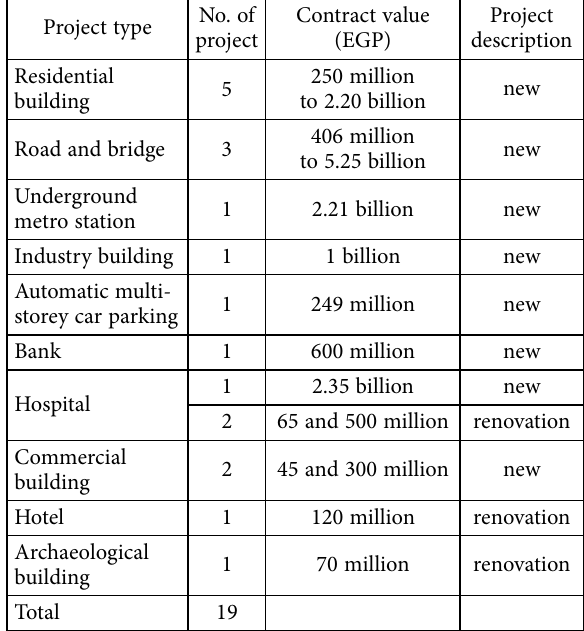
Table 2. Description of the sample size projects